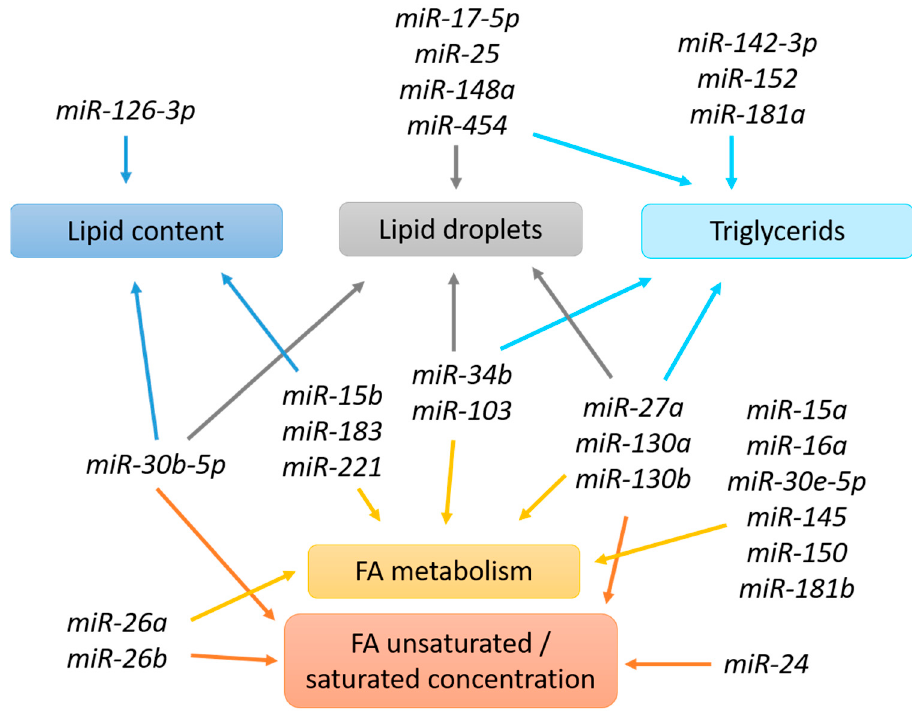
Figure 6. miRNAs involved in the regulation of lipid biosynthesis in mammary epithelial cells. Colour-coded arrows show which processes the mentioned miRNAs are involved in.